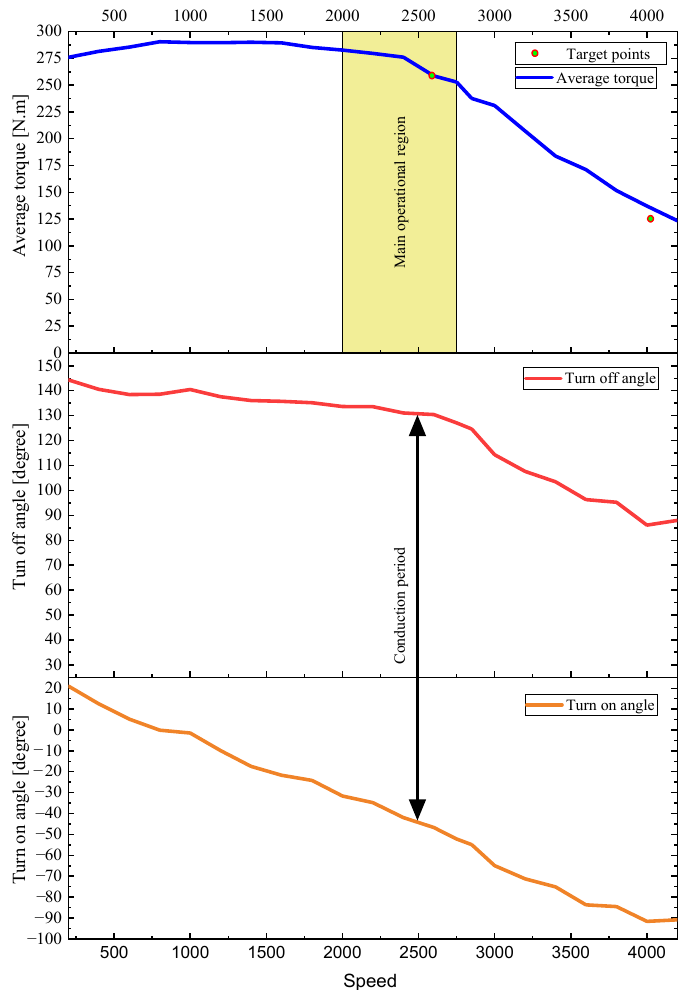
Figure 25. The torque required for critical speed points of 2600 rpm and 4000 rpm are achieved.